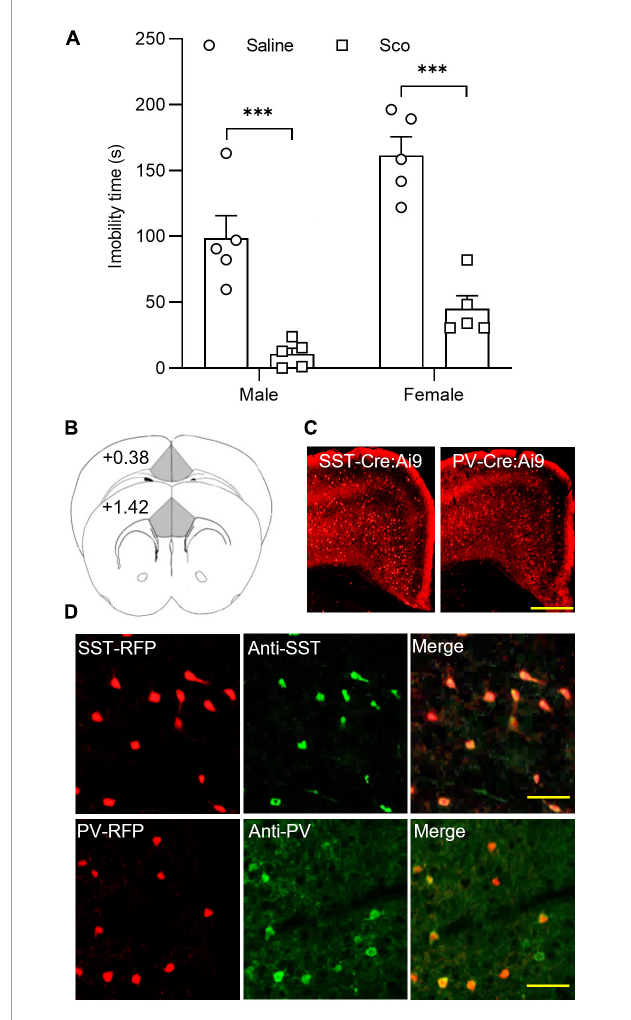
FIGURE1 The effects of scopolamine on the forced swim test and RFP-expressing neurons in the ACC of SST-cre/Ai9 and PV-cre/Ai9 mice. (A) Plots show the effect of scopolamine injection (3 mg/Kg, i.p.) on the immobility time of the forced swim test (FST) in male (P40-60, n = 5 for each group, left panel) and female C57BL/6J mice (P40-60, n = 5 for each group, right panel). Control mice were injected the same volume of saline. The FST was performed 60 min after injection. (B) A diagram illustrates the location of the ACC in coronal sections of the mouse brain. (C) Fluorescent images show the distribution of red fluorescent protein (RFP) positive neurons in the anterior cingulate cortex (ACC) from an SST-cre/Ai9 mouse (left) and a PV-cre/Ai9 mouse (right). Scale bar: 100 µ m. (D) Immunohistochemistry shows the staining of RFP neurons to SST antibody (green) in an SST-cre/Ai9 mouse brain section (upper panel) and PV antibody (green) in a PV-cre/Ai9 mouse brain section. Scale bar: 50 µ m. Scop, scopolamine; ACC, anterior cingulate cortex; SST, somatostatin; PV, parvalbumin; RFP, red fluorescent protein. ∗∗∗ p <